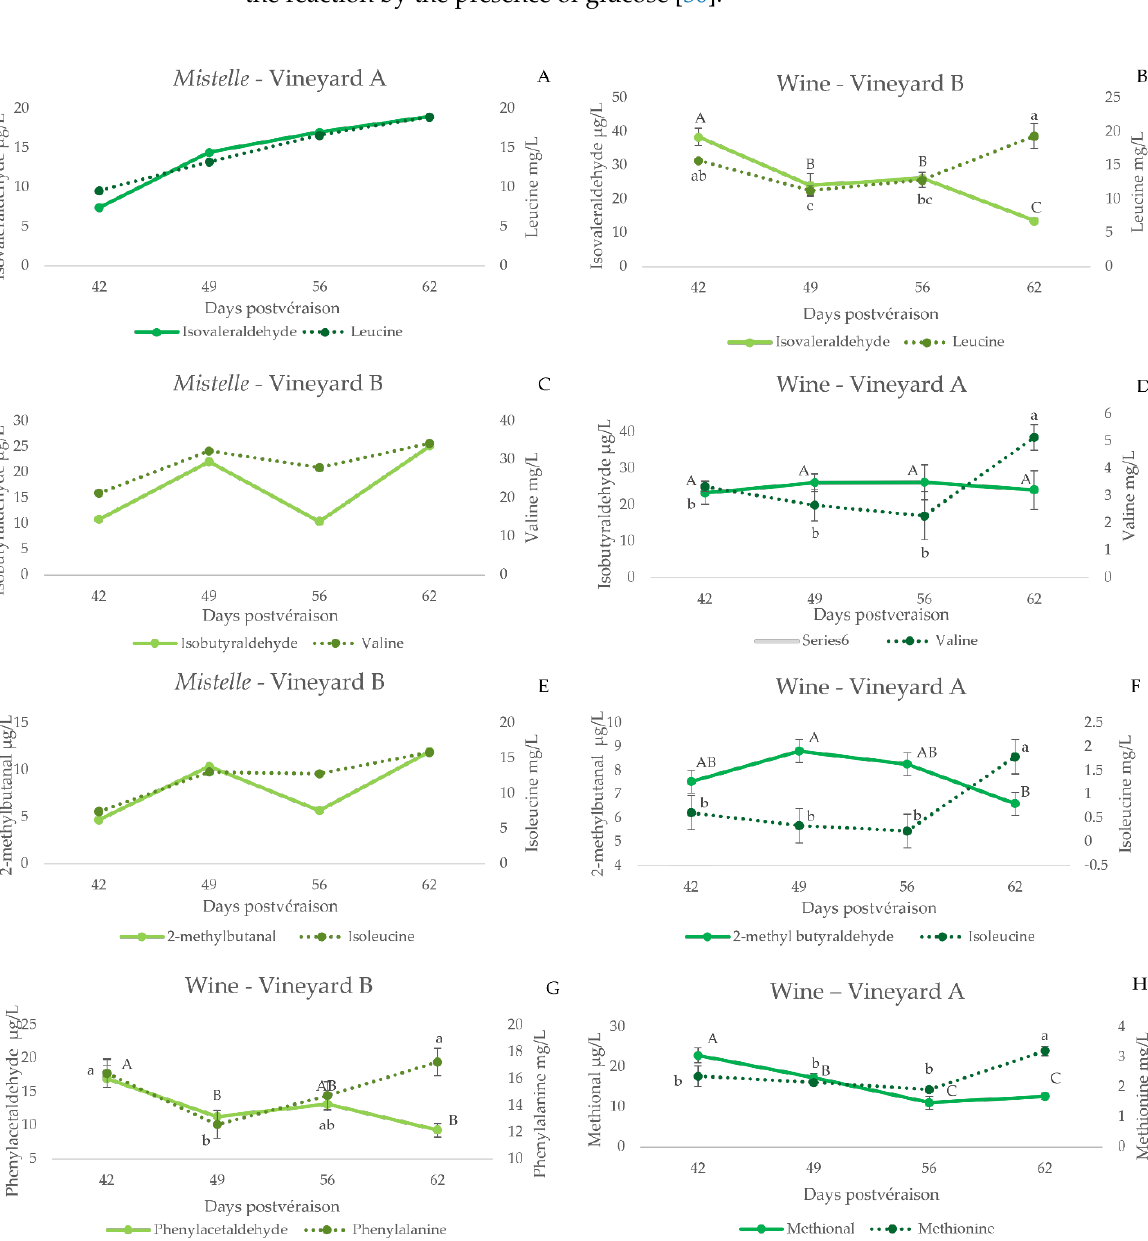
Figure 2. Evolution of some Strecker aldehydes and their amino acid precursors in mistelle samples ( A , C , E ) or in wines ( B , D , F , G,H ) made with grapes sampled from specific vineyards at different degrees of ripeness (expressed as days post-veraison). Error bars are calculated as s/( n ) 1/2 (s, standard deviation; n = 3). Different letters indicate significant differences in the content of the compounds ( p < 0.05) (Fisher post hoc test) (upper case: aldehydes; lower case: amino acids).